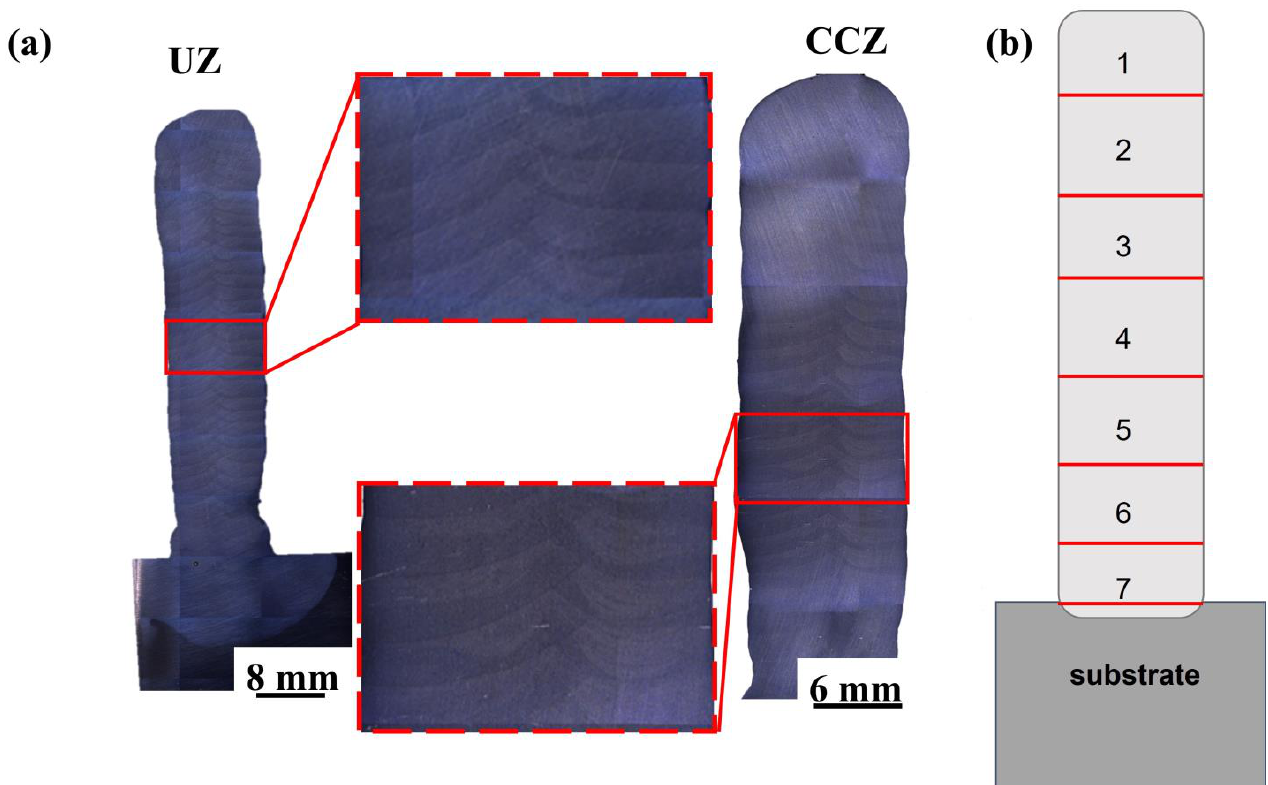
Figure 2. ( a ) Sectional view of the forming part and ( b ) schematic diagram of metallographic sampling.